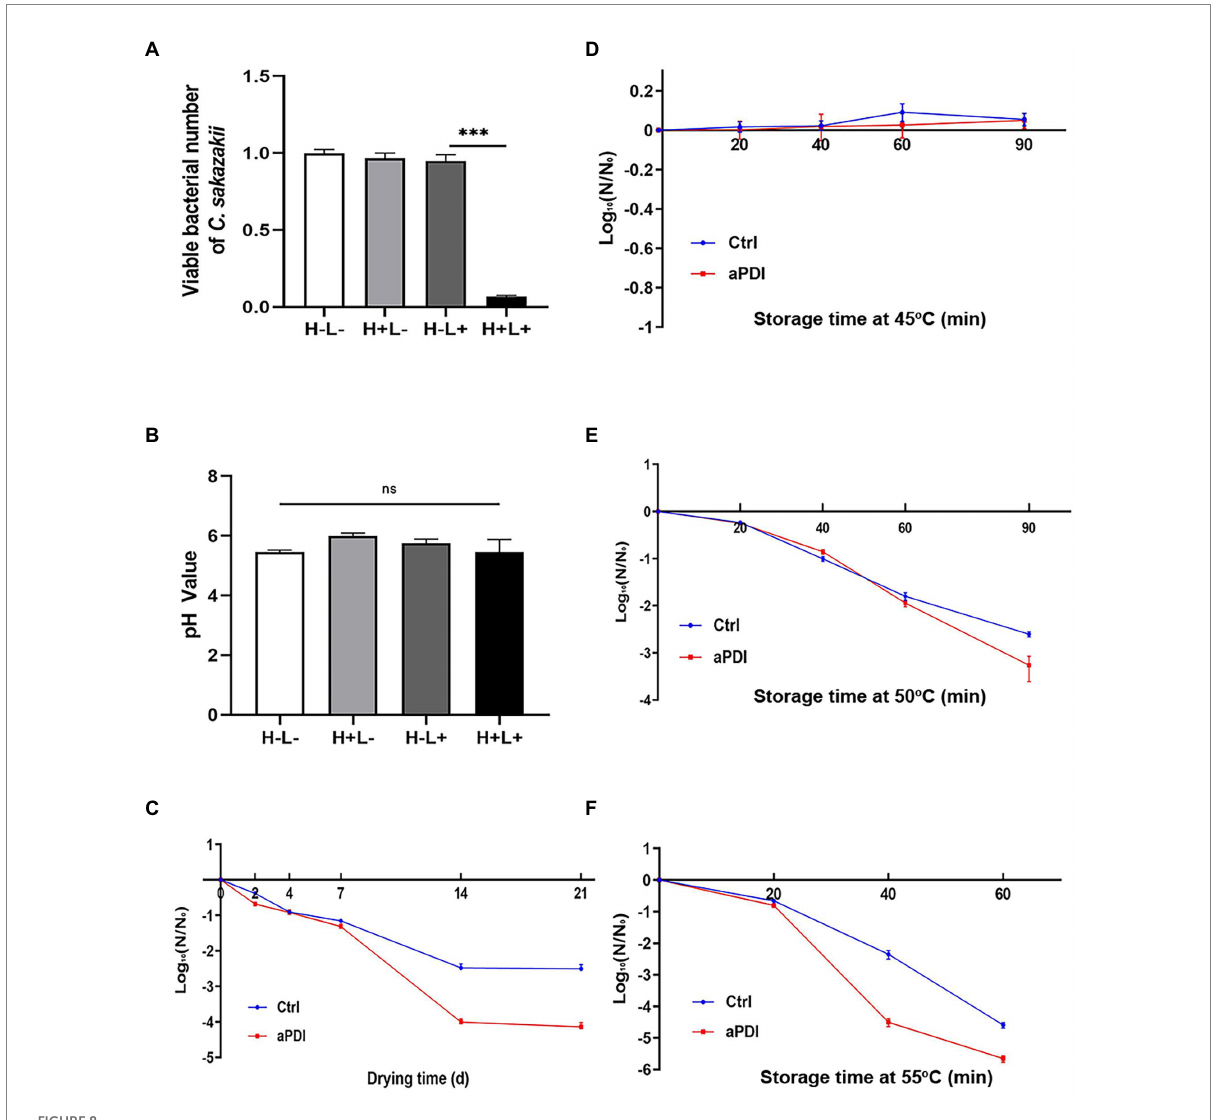
FIGURE 8 Effect of aPDI on PIF contaminated by C. sakazakii . C. sakazakii was first inoculated into powdered infant formula (PIF) in a ratio of 1:20 (w/w) to establish a contamination model. The contaminated PIF was then transferred to a 24-well plate for aPDI sterilization. The viable cells were subjected to plate counting in the experimental and controlled groups (A) . The food quality upon treatment was assessed by measuring pH values of infant formula (B) . The bacterial resistance to desiccation was then evaluated by incubating the aPDI-treated PIF in an air-drying chamber. The samples were collected from various length of days (2, 4, 7, 14, and 21), and subjected to viable cell enumeration (C) . The results are expressed as log 10 (N/N0). N is the microbial population after drying (CFU/g), while N0 is the initial cell number before drying (CFU/g). The similar procedure was applied to heated stress trials, wherein varying temperatures, like 45 ° C (D) , 50 ° C (E) and 55 ° C (F) , were designed to study the survival rate of C. sakazakii in the reconstituted PIF. Samples were collected in the time intervals of 20, 40, 60, and/or 90 min, respectively. Values are the mean ± SEM (standard error of mean) from 4 replicates. * p < 0.05, ** p < 0.01, *** p < 0.001, ns, p >